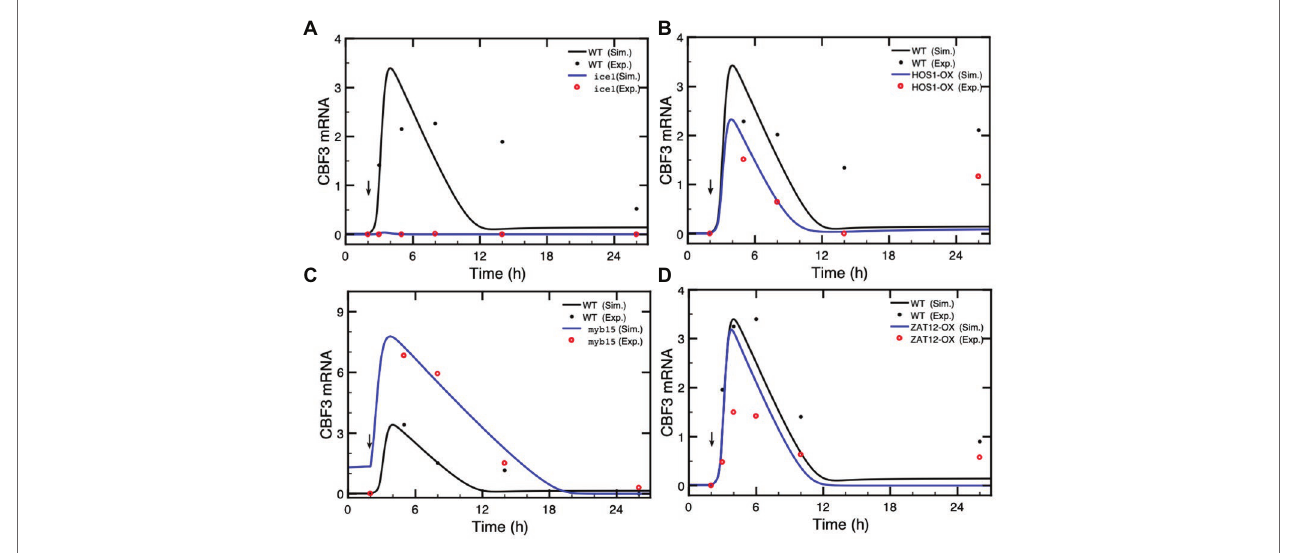
FIGURE 5 | Effect of loss-of-function mutations or overexpression (OX) of genes in the cold response pathway. The expression of CBF3 is determined in the model after a cold shock given at time = 2 h (vertical arrow) in the form of a Ca 2+ pulse. In each panel, we compare the simulated CBF3 mRNA levels in wild type (WT, black curves), and mutants (blue curves) with the CBF3 mRNA level determined experimentally in WT (black dots) and in mutants (red dots) in (A) the ice1 mutant, (B) the overexpression of the HOS1 gene (HOS1-OX), (C) the myb15 mutant, and (D) the overexpression of ZAT12 (ZAT12-OX). In each panel, the time at which experimental points were taken is increased by 2 h because in the simulations the cold stress is given at time = 2 h instead of 0 h in the experiments (thus a point measured at 6 h is plotted at 8 h in Figure 4B , to allow the comparison between the simulations and the experimental results). The theoretical curve (black line) obtained by simulations for the WT is the same in all panels—the changed scale in panel (C) is due to higher levels of CBF3 mRNA in the myb15 mutant—while the experimental points for the WT (black dots) are taken from different publications, as mentioned hereafter. In (A) , the value of ICE1 synthesis rate in the ice1 mutant is 0.036, compared to 0.18 in WT (see Supplementary Table 2 for units of the parameters). Experimental data are redrawn, by means of the software ImageJ for Image Processing and Analysis (https://imagej.nih.gov/ij/), from Figure 1C in Chinnusamy et al. (2003). In (B) , the total amount of HOS1 protein in HOS1-OX is 10, vs. 2 in WT. Experimental data for CBF3 expression in HOS1-OX are redrawn from Figure 7B in Dong et al. (2006). The peak in CBF3 expression at 24 h (corresponding to time = 26 h in Figure 4B ) is also observed in the wild type; see Figure 7B in Dong et al. (2006). This increase is not accounted for by the model (see “Discussion” section). In (C) , the total amount of MYB15 protein in the myb15 mutant is 0.2, vs. 2 in WT. Experimental data are redrawn from Figure 7C in Agarwal et al. (2006). In (D) , the synthesis rate is 11 in ZAT12-OX, vs. 2.2 in WT. Experimental data are redrawn from Figure 10A in Vogel et al. (2005). Parameter values are listed in Supplementary Table 2 except for vs1 = 0.036 nM/h, vs3 = 11 nM/h (overexpression of ZAT12), HOS1 t = 10 nM, and MYB15 t = 0.2 nM. The results are obtained by numerical integration of kinetic equations (1) and (4)–(17) from Supplementary Material Sections 1 and 2, using the XPP program (http://